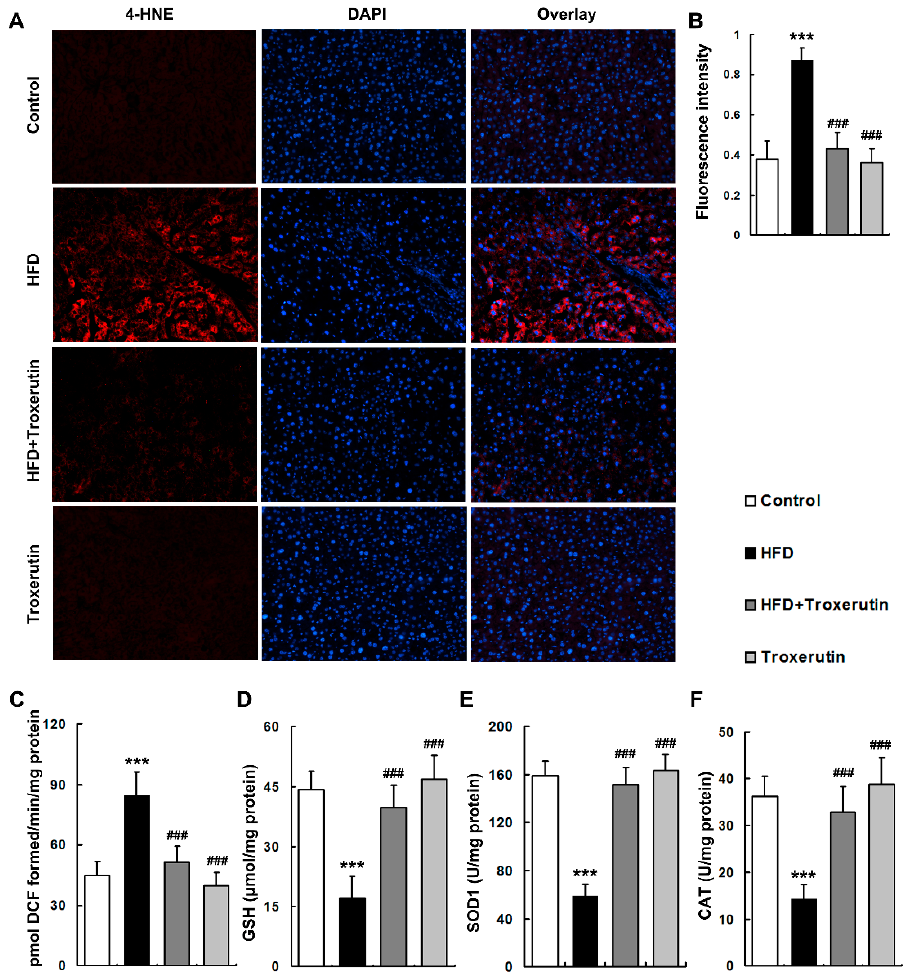
Figure 4. Troxerutin suppresses oxidative stress in HFD-treated mouse livers ( n = 5). ( A ) 4-HNE immunofluorescence staining, 200 × magnification; ( B ) 4-HNE fluorescence intensity was measured as the mean OD value; ( C ) ROS productions in mouse livers; ( D ) GSH contents in mouse livers; ( E ) SOD1 activities in mouse livers; ( F ) CAT activities in mouse livers. All of the values are expressed as the mean ± SD. *** p < 0.001 vs. the control group; ### p < 0.001 vs. the HFD group.